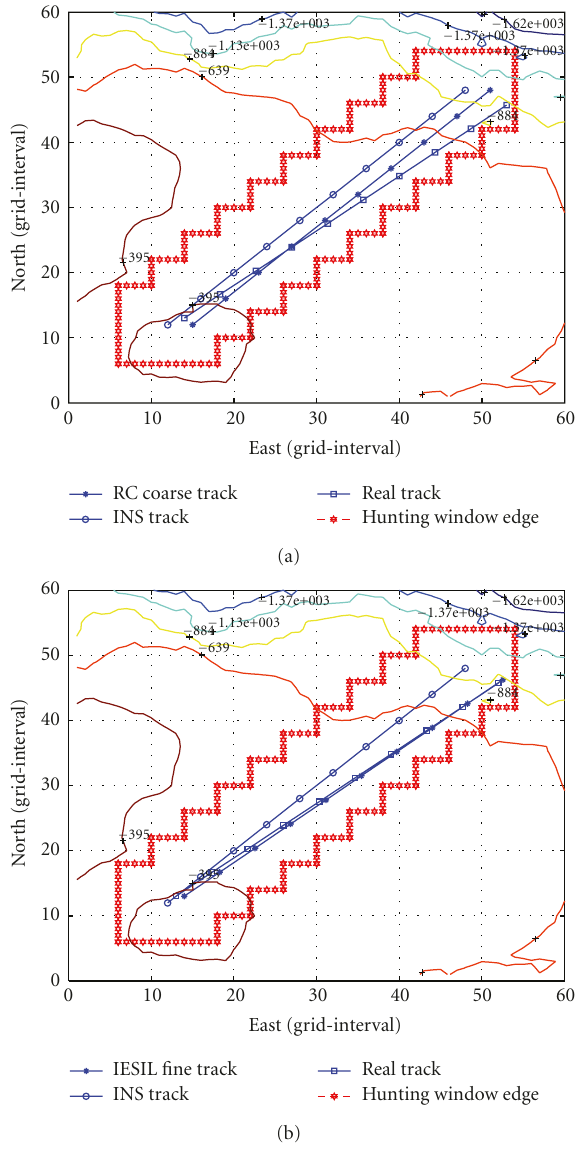
Figure 5: Results of simulation experiments: (a) RC coarse- positioning, (b) IESIL